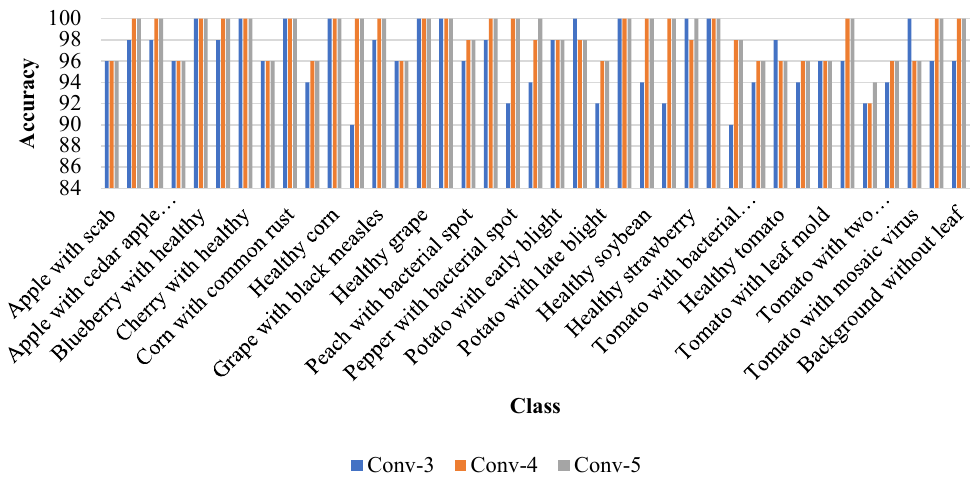
Figure 16. Testing accuracy of individual classes for proposed Conv-3 DCNN, Conv-4 DCNN, and Conv-5 DCNN.